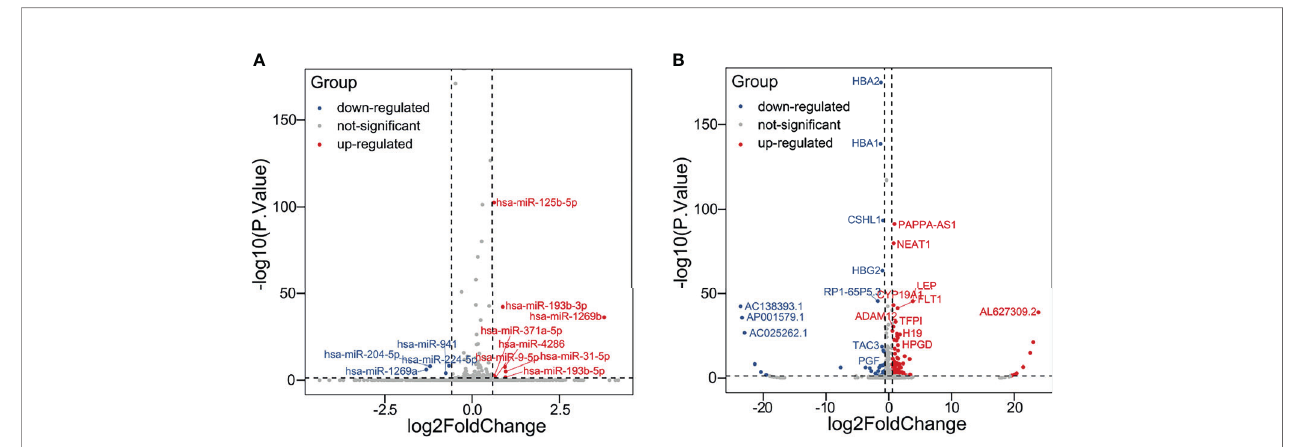
FIGURE 2 | Identi fi cation of DEmiRs and DEGs. Volcano plots illustrating (A) DEmiRs and (B) DEGs in placental tissues determined by comparing IVF-ET (n = 3) with normal conception (n = 3) pregnancies. Differential expression thresholds employed for deriving DEmiRs and DEGs involved foldchange (FC) >1.5 and P < 0.05. Red and blue points represent signi fi cantly upregulated or downregulated miRNAs/mRNAs,